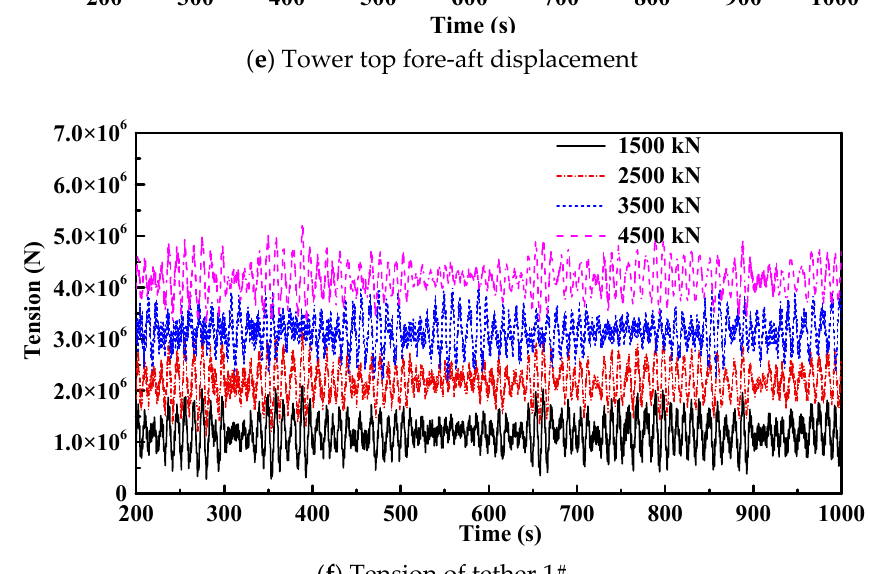
Figure 11. Time series of platform motion, tower fore-aft displacement and tension of tether 1# in different pretension conditions.